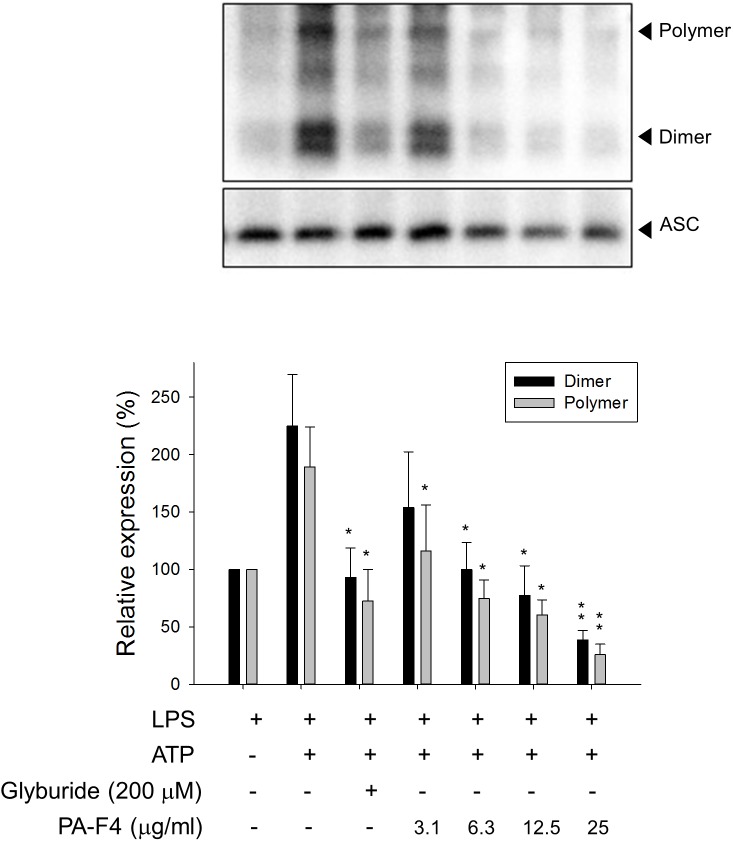
Effect of PA-F4 on ATP-induced ASC dimerization and oligomerization. THP-1 cells were seeded and differentiated by 50 nM PMA. After 48 h, cells were primed with 1 μg/mL LPS for 4 h. Then, cells were pre-treated with or without the indicated agent for 0.5 h and then co-treated with 5 mM ATP for another 2 h. After treatment, the cells were harvested for the detection of the protein expressions of ASC dimerization and oligomerization. Data are expressed as mean ± SEM of four to five independent determinations. One-way ANOVA by Newman–Keuls post hoc test is used. ∗P < 0.05, ∗∗P < 0.01 compared with LPS plus ATP. The analysis of P (ANOVA) indicates the following: for dimer group, P < 0.001; for polymer group, P = 0.004.